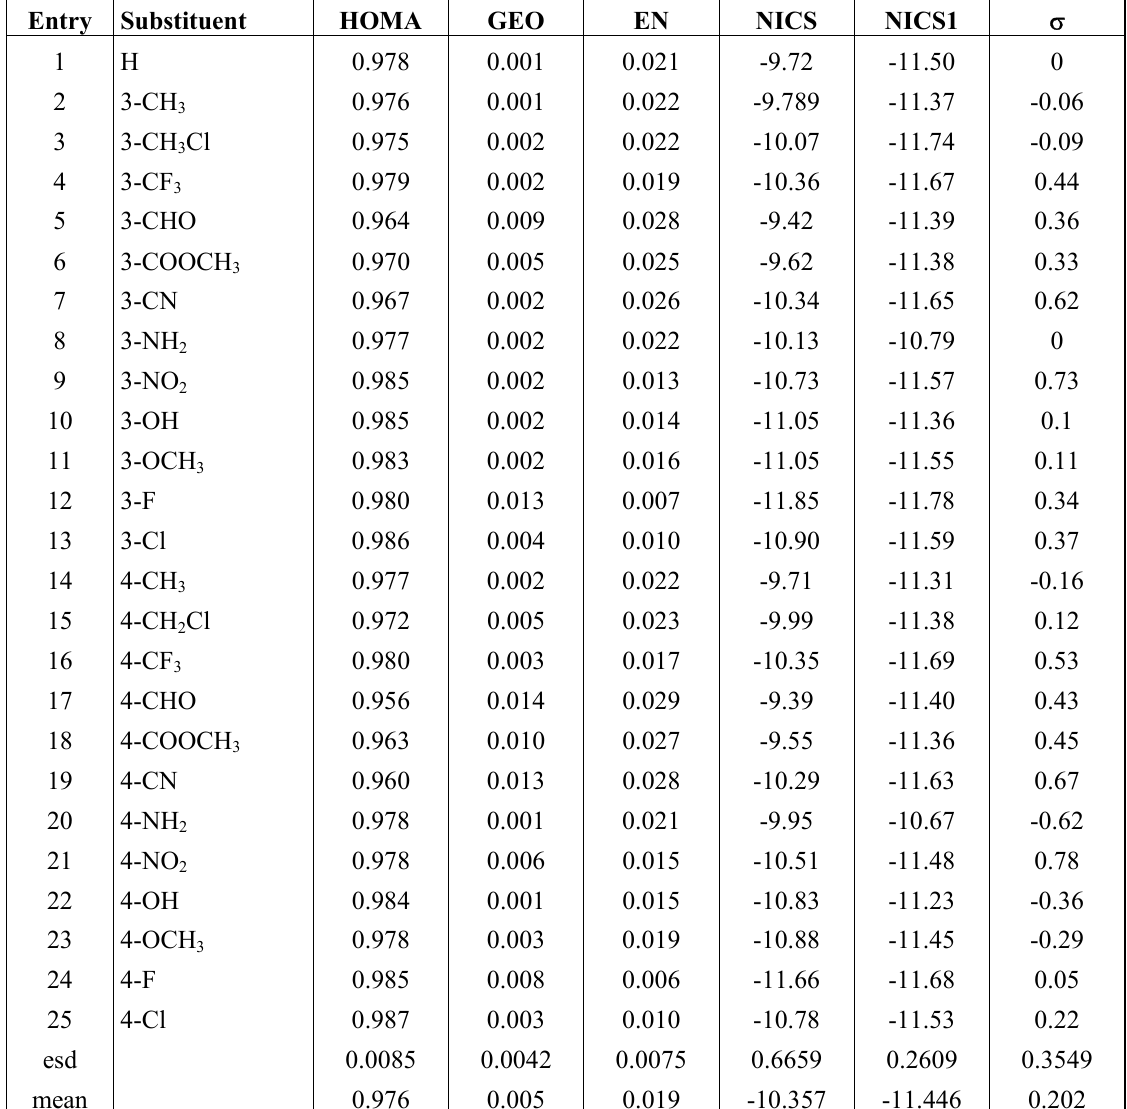
Table 2. Computation of HOMA, EN, GEO, NICS and NICS(1) for 25 meta– or para– derivatives of benzoate